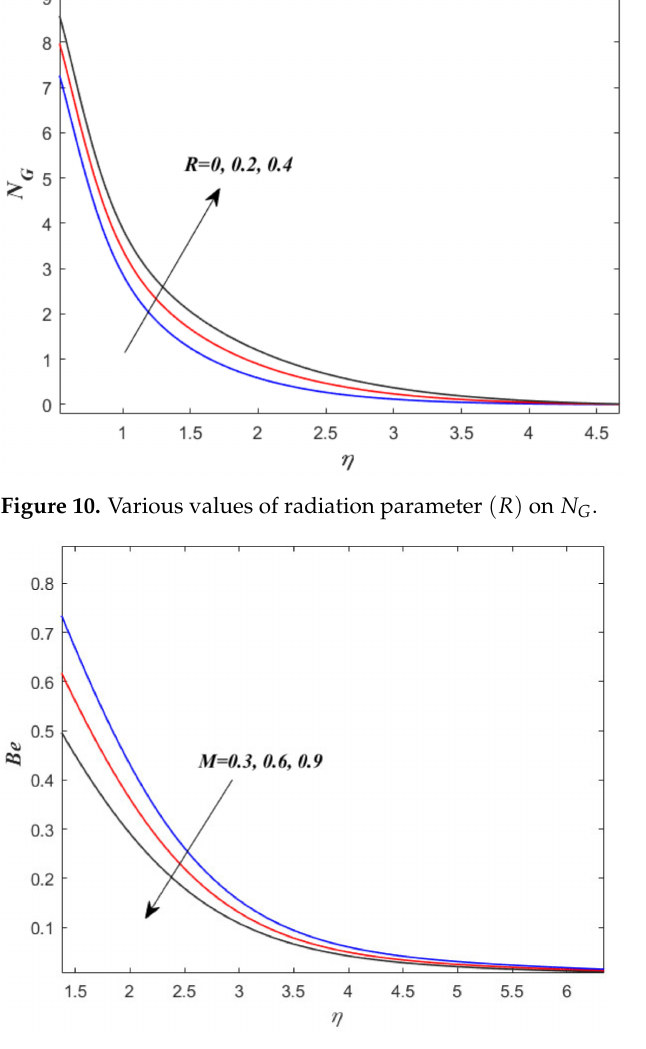
Figure 11. Various values of magnetic parameter ( M ) on Be .